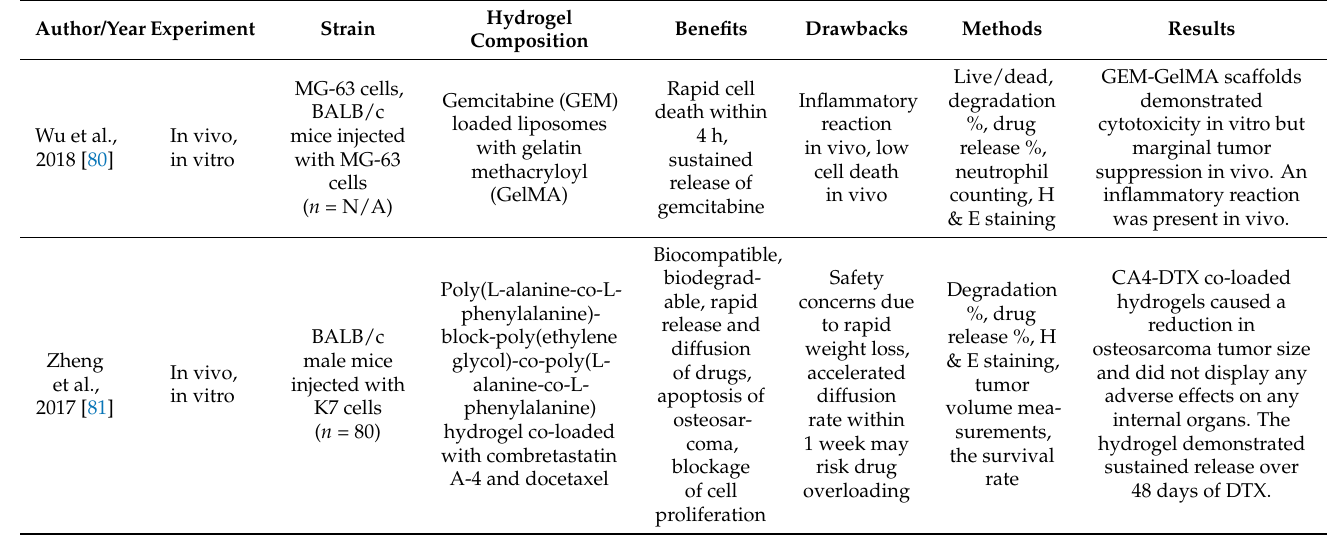
Table 1. Summary of studies treating